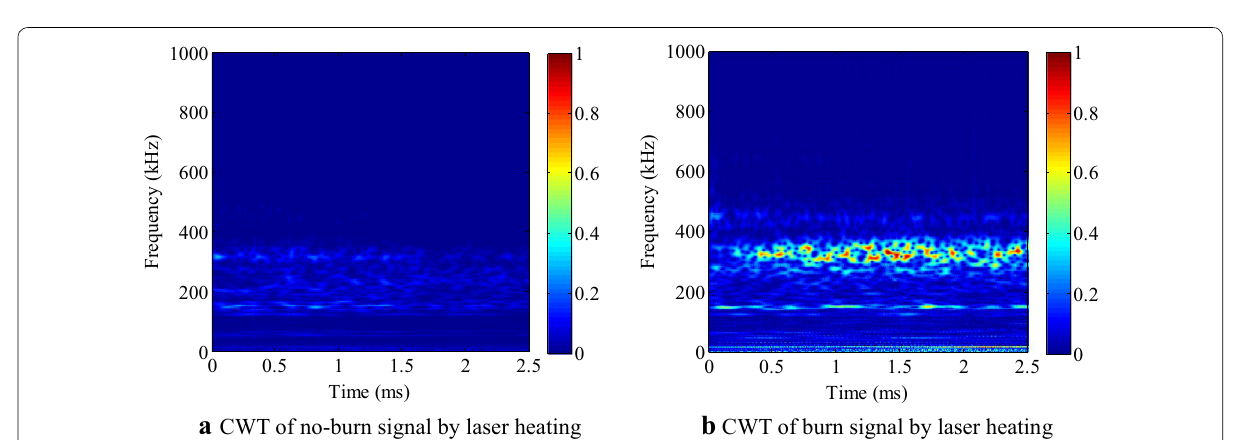
a CWT of no-burn signal by laser heating b CWT of burn signal by laser heating Figure 6 AE signals produced by laser